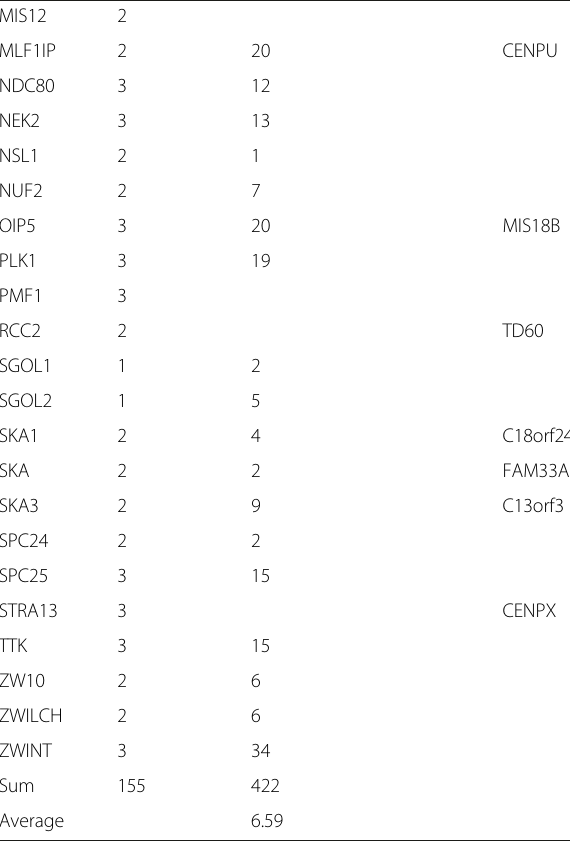
Table 1 The 64 core centromere-kinetochore components as queries for database searches